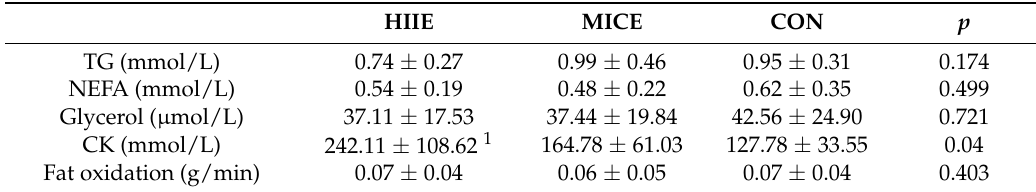
Table 2. Plasma concentrations in the fasted state at the baseline on Day 2 of each trials.